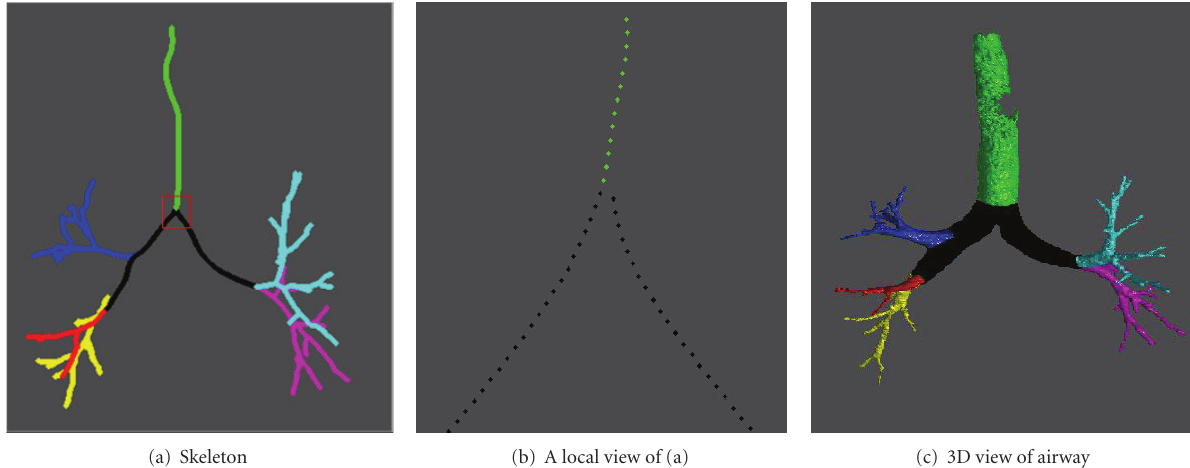
Figure 8: An example where a missing part of the trachea is missed by the airway segmentation scheme.